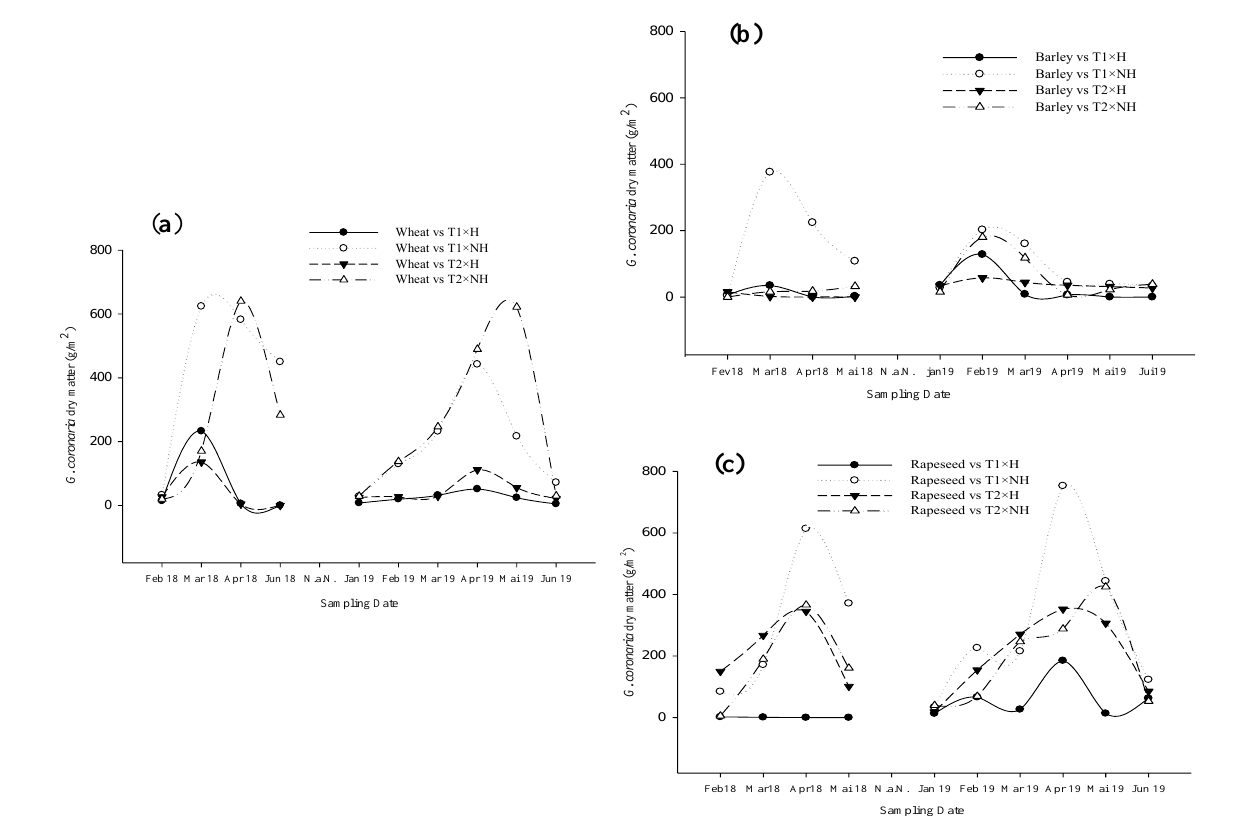
Figure 6. Effect of the interaction tillage × herbicides on the dry matter evolution of G. coronaria (g/m 2 ) throughout 2017–2018 and 2018–2019 growing seasons, ( a ): wheat; ( b ): barley; ( c ) rapeseed. In the wheat plots, the biomass was significantly reduced by herbicide treatments for both seasons (Figure